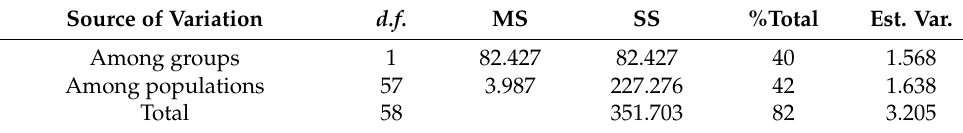
Table 4. Analysis of molecular variance (AMOVA) among E. indica populations and clustered groups. Source of Variation d.f. MS SS %Total Est. Var. Among groups Among